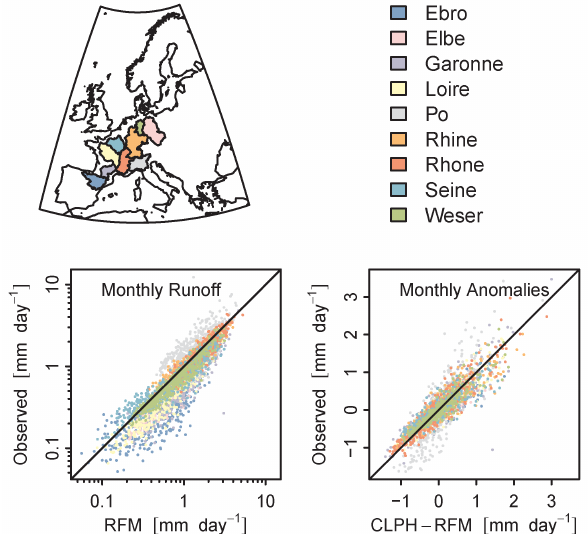
Figure 9. Basin-scale validation (A): top, nine continental-scale river basins used for model validation. Bottom, comparison between observed monthly river discharge to river discharge estimates de- rived from the random forest model with full atmospheric forcing (left) and comparison between observed and modelled monthly dis- charge anomalies (right). The similarity between observed an mod- elled river discharge is quantified in Fig.